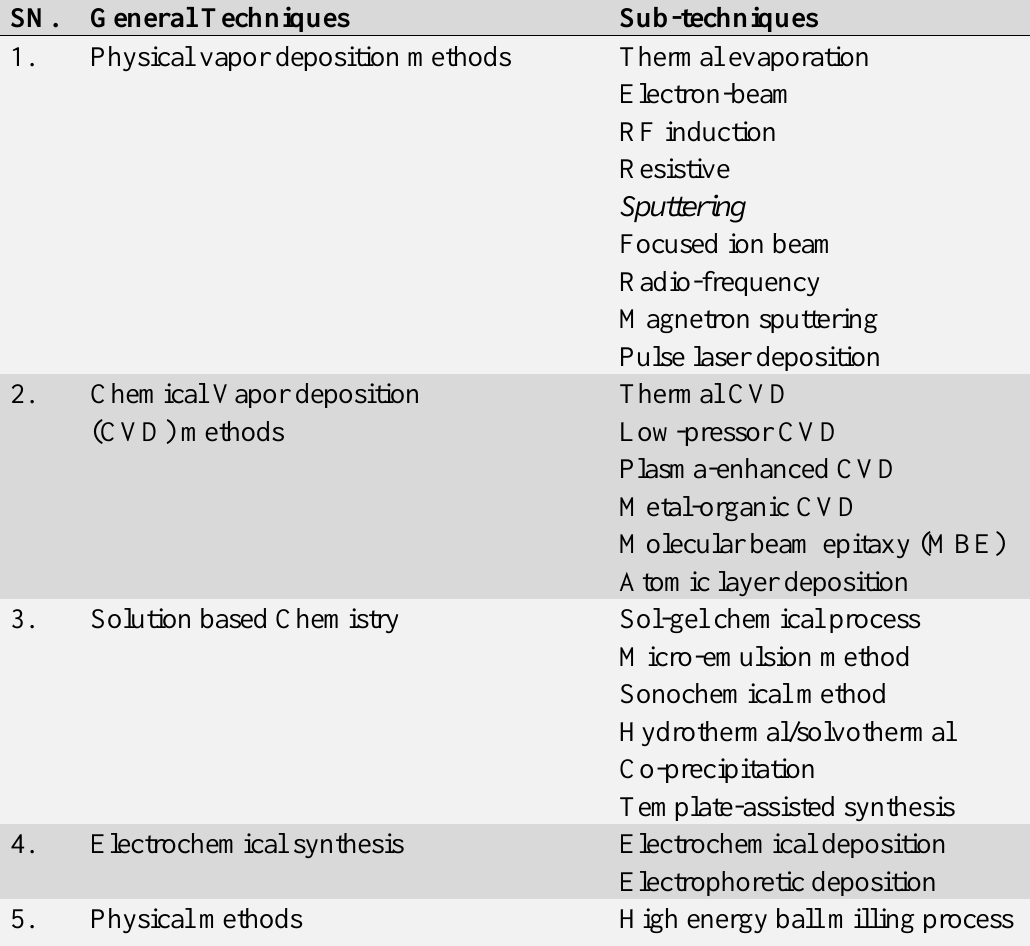
Table1. Several deposition and synthesis methods of nanomaterials.